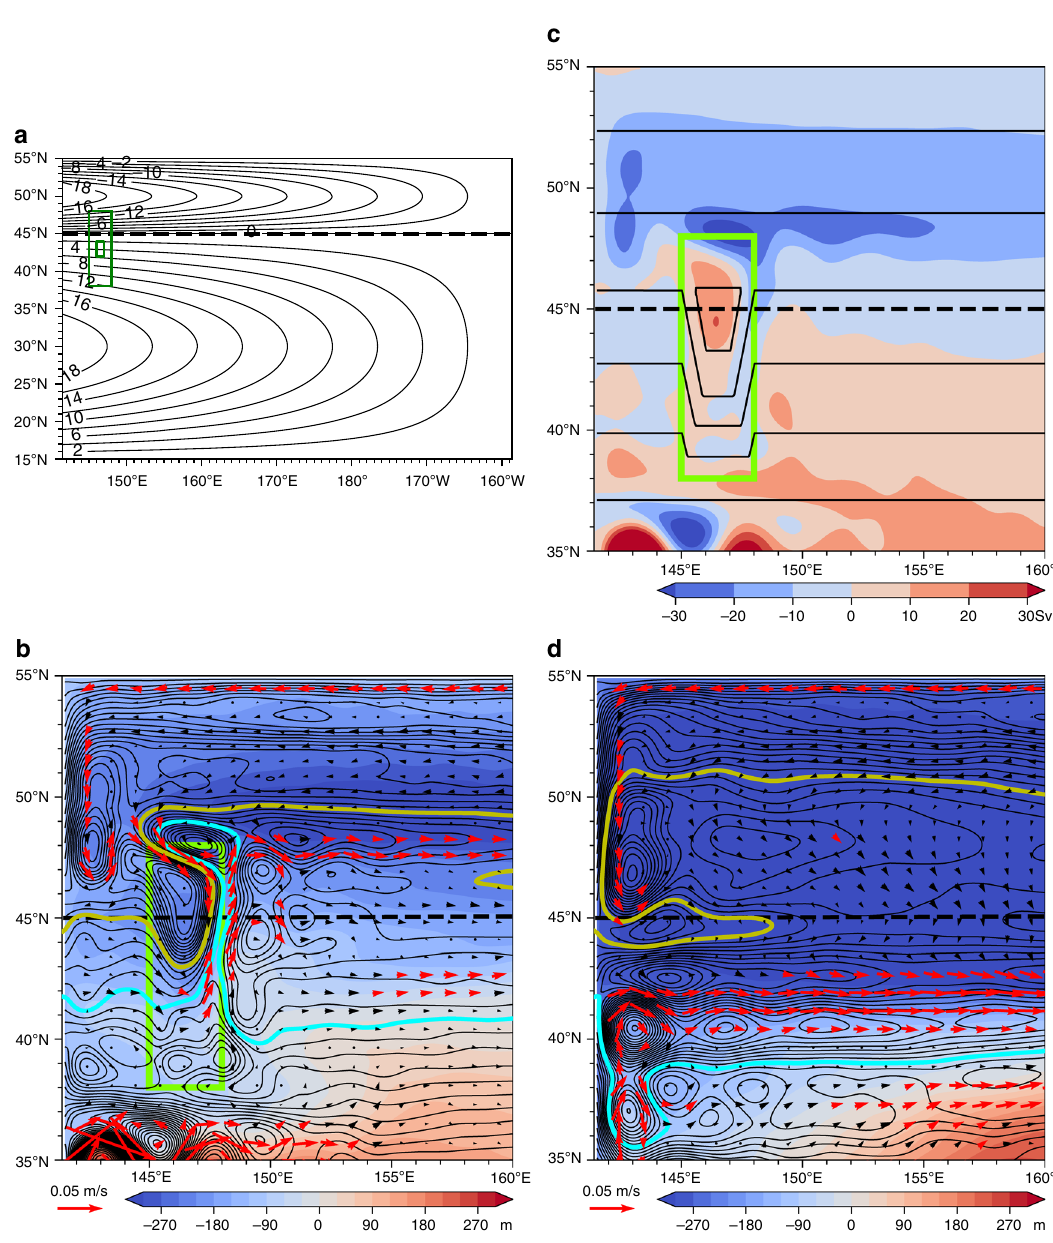
Fig. 6 Idealized two-layer simulation. a Model basin with a depth of 5500 m. The bottom topography with a height of 500 m is depicted by green lines denoting ocean depth contours of 5500 m and 5000 m. Solid contours denote wind-driven transport function (×10 6 m 3 s − 1 ). b Bottom Topography Case. Upper layer thickness anomaly (color shade; m), upper layer velocity (arrow) and characteristic curves Q c with a contour interval of 0.5 × 10 6 m 3 s − 1 are shown. Green box denotes the location of bottom topography. c Barotropic streamfunction (shade ×10 6 m 3 s − 1 ) and f / H (contour interval 0.1 × 10 − 8 m − 1 s − 1 ) for Bottom Topography Case. Green box indicates the location of bottom topography. d Same as b but for No Bottom Topography